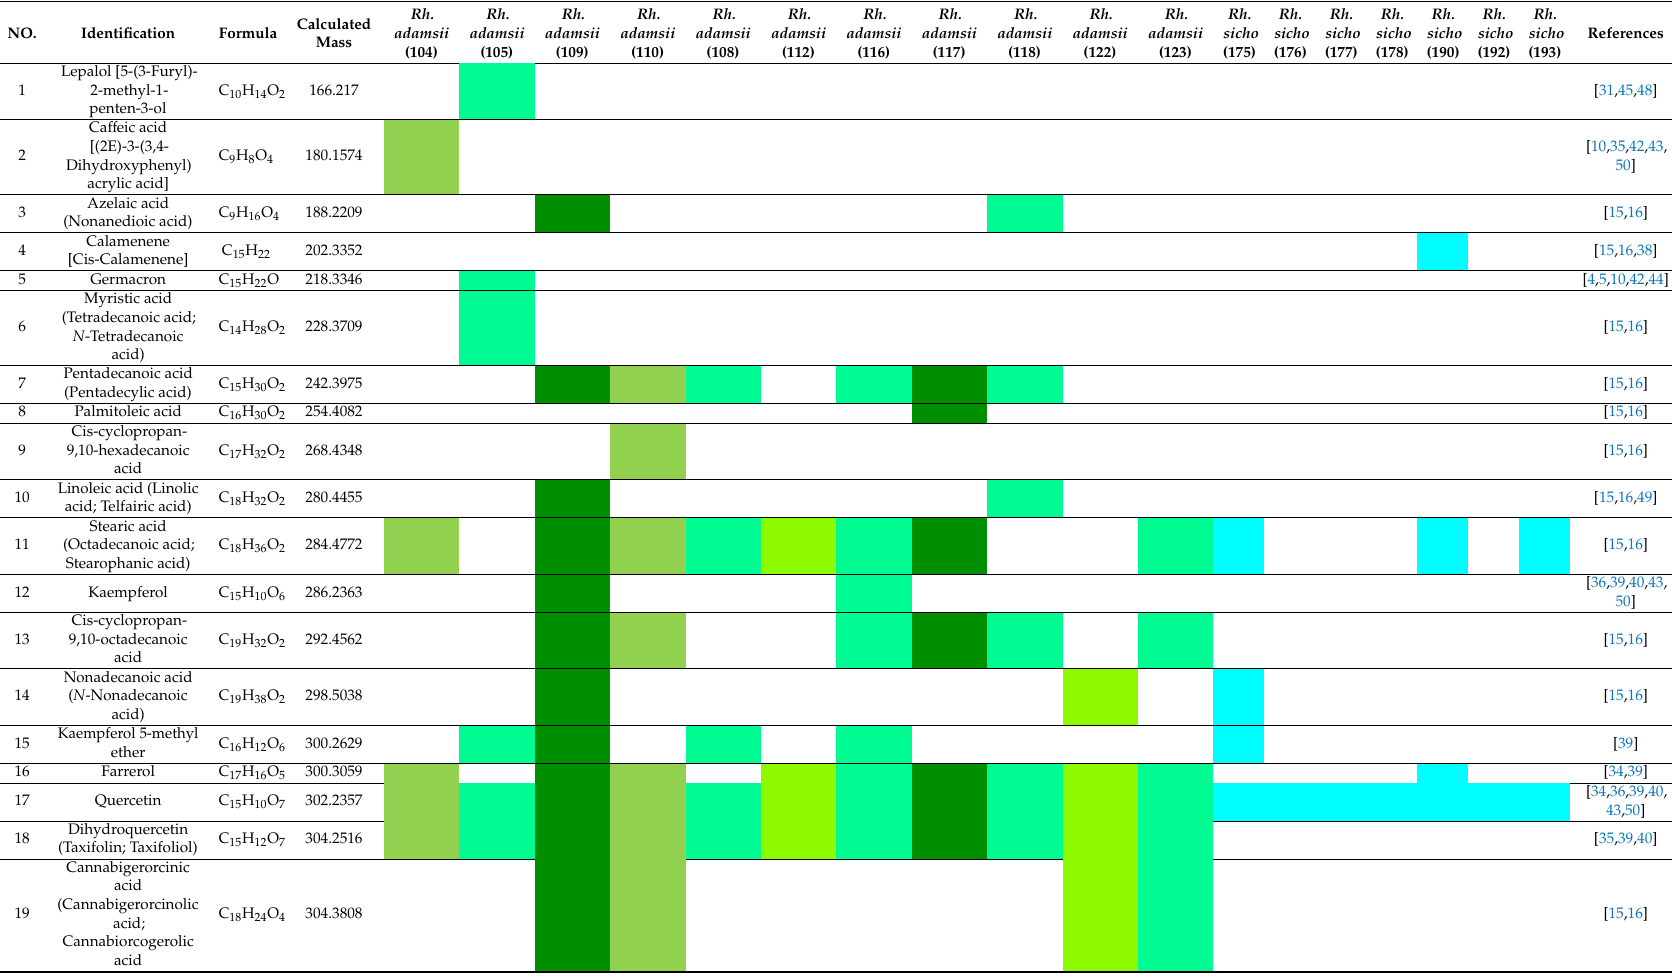
Table 3. Compounds identified from SC-CO 2 extracts by two varieties of rhododendron: Rh. sichotense and Rh.